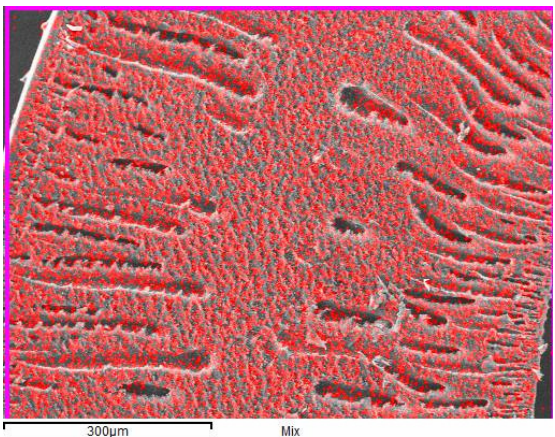
Figure 1. The EDX mapping analysis for the cross-sectional image of resultant MMHFM. The red dot represents the location of Al element.